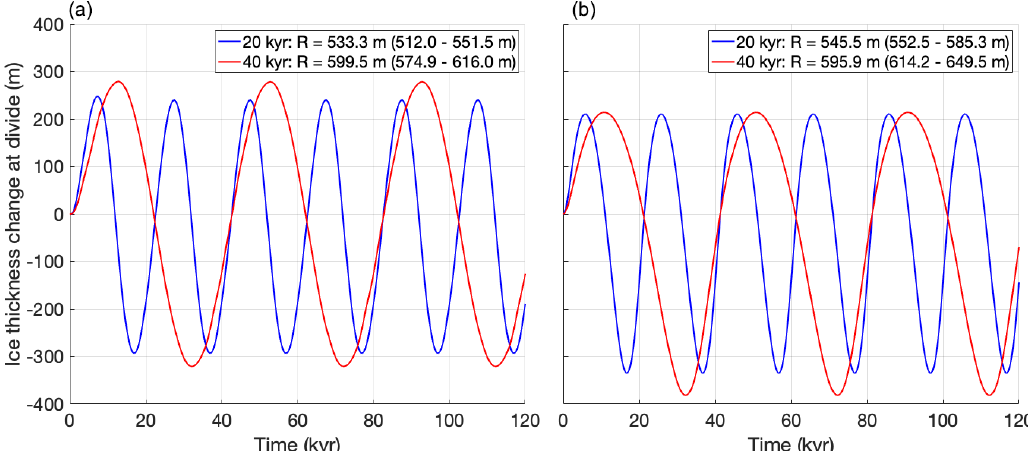
Figure 4. Ice thickness at the divide over time for the “glacial cycle” experiments from the first EISMINT intercomparison exercise, with a moving margin (a) and a fixed margin (b) . The legends list the simulated glacial–interglacial difference R for the last cycle, with the range of numbers reported by Huybrechts et al. (1996) listed in parentheses for comparison.